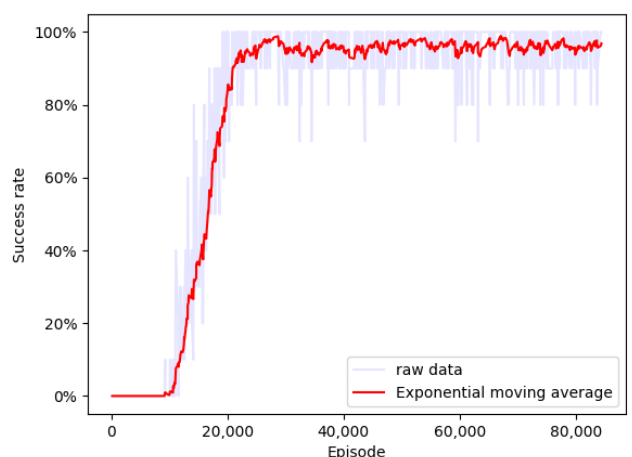
Figure 7. Simulation: success ratio of the proposed path planning in